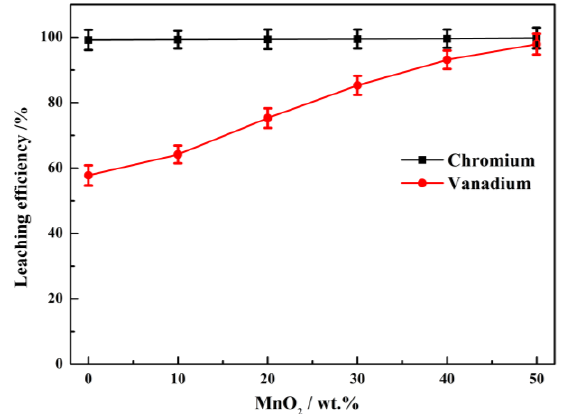
Figure 5. Effect of MnO 2 dosage on the leaching efficiency of vanadium and chromium.